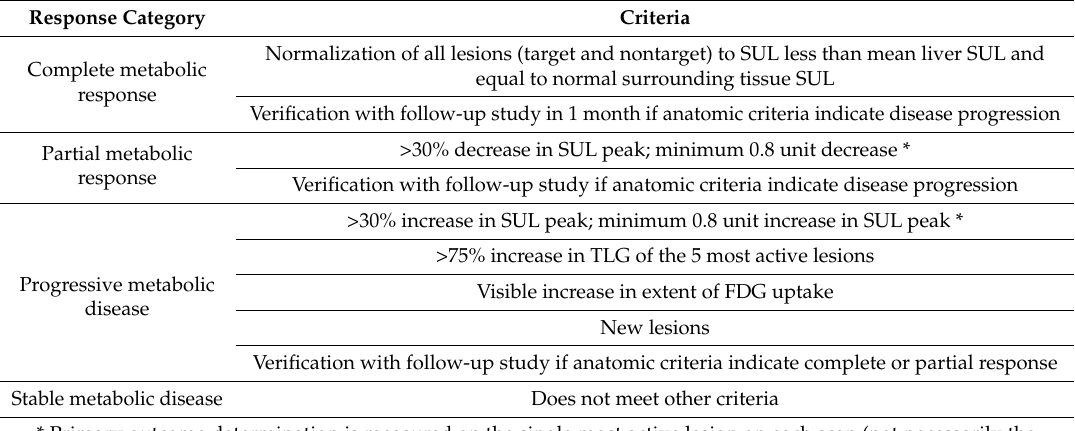
Table 4. Positron Emission Tomography Response Criteria in Solid Tumors (PERCIST)